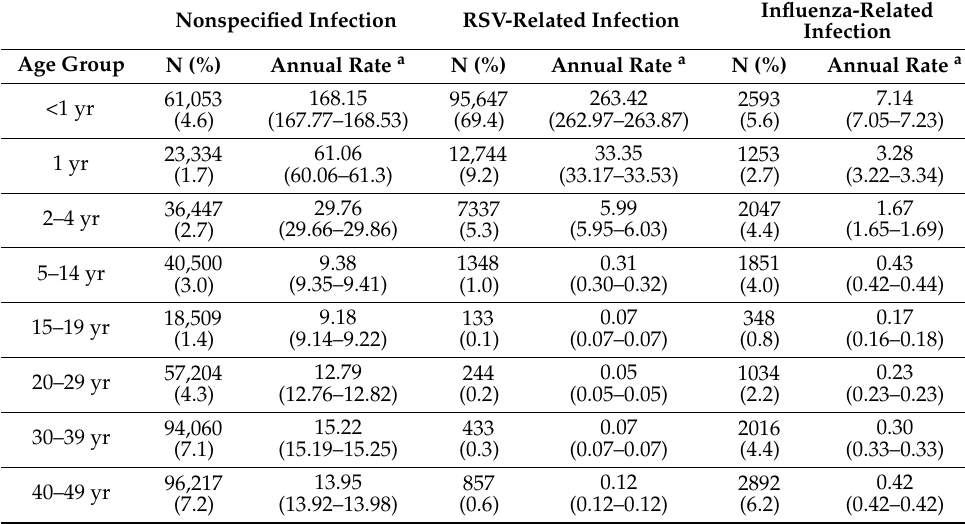
Table 3. Hospitalization rate in the general population in Spain by diagnostic group and age group between 2012 and